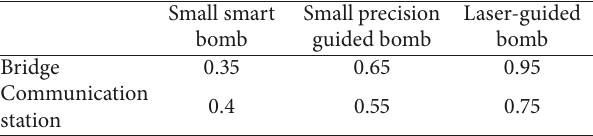
Table 1: Weapon-target combat ability